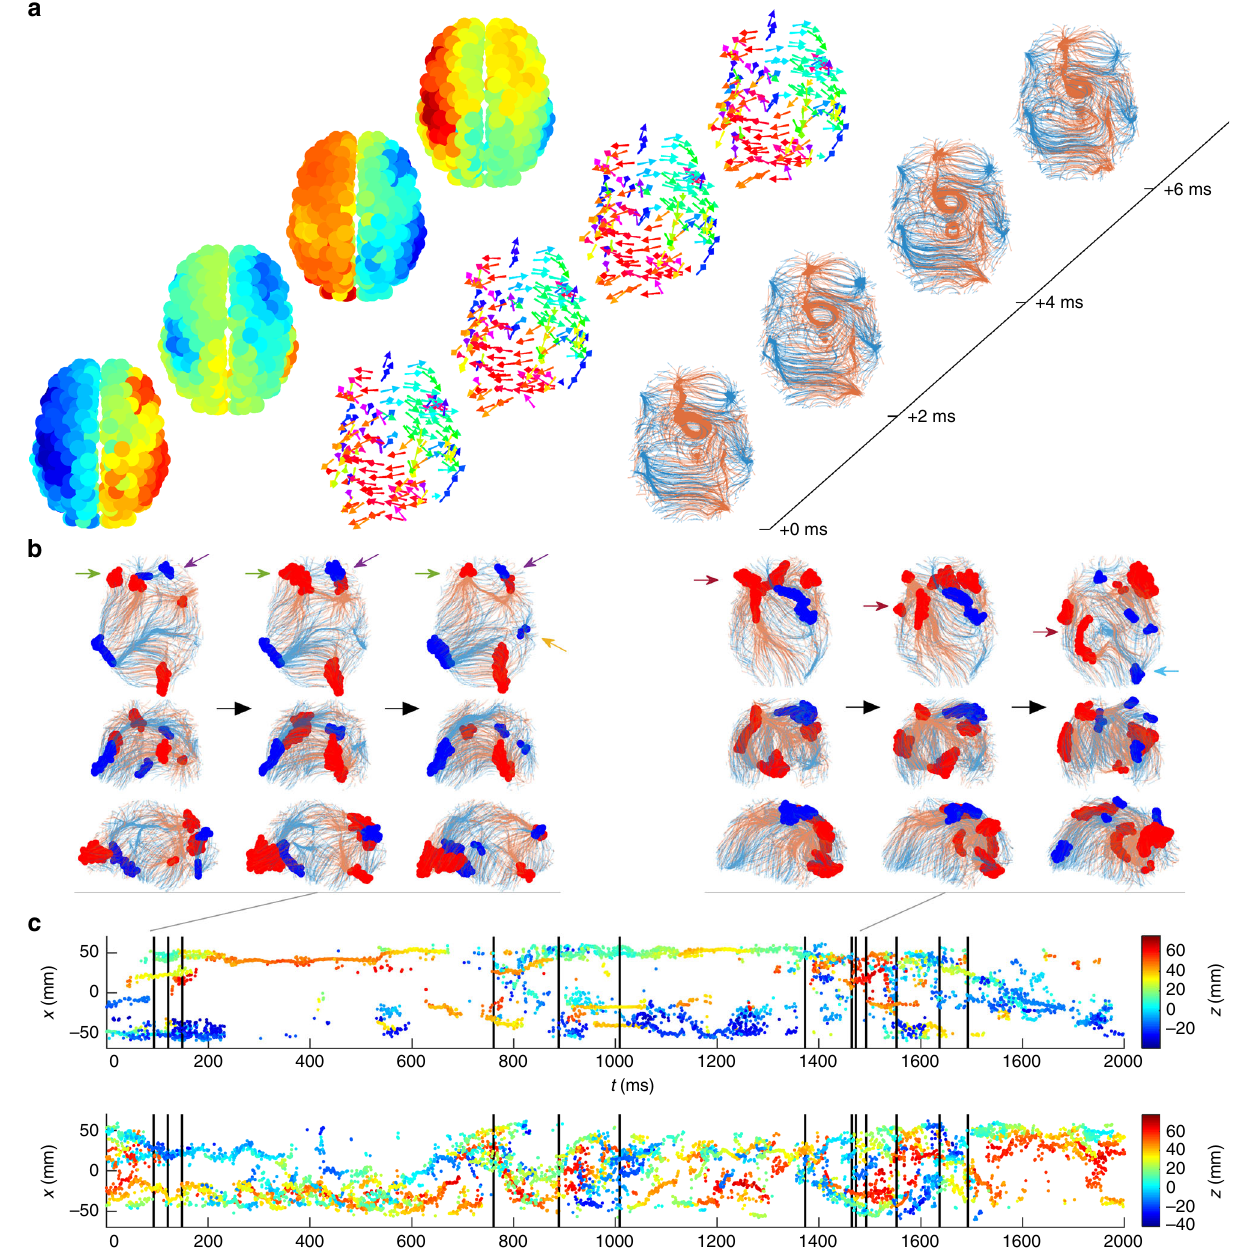
Fig. 6 Phase fl ow tracked across space and time. a Snapshots of waves (left, colored by voltage as in Fig. 1), the corresponding phase fl ow vectors (middle, colored by orientation in the 2D plane shown), and phase fl ow streamlines (right, blue and red denote forward and backward streamlines, respectively). b Exemplar streamlines near metastable transitions, colored as in a , viewed from the top, back, and right (rows 1 – 3, respectively). Shown are two sets of three snapshots, each surrounding a transition as indicated (gray) in the panel below. Highlighted points ( fi lled circles) denote clusters that form sources (red) and sinks (blue). Black arrows denote the progression of time; colored arrows denote the features referred to in the text. c Lateral positions (displacement from the midline, x ) of sinks (top) and sources (bottom) plotted across time, colored by vertical (dorsoventral) position z . Vertical black lines denote transition times calculated using interhemispheric